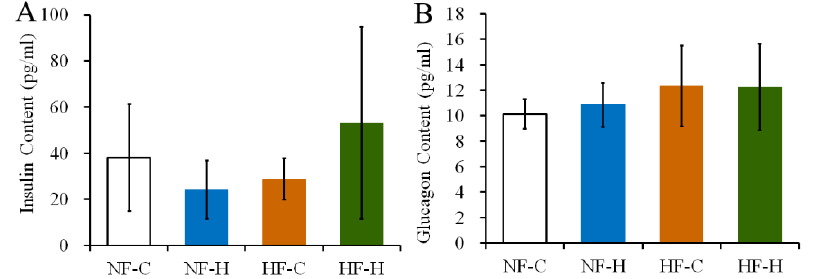
Figure 4. Effects of CPF on serum contents of insulin ( A ) and glucagon ( B ) in rats treated under the NF diet and HF diet. CPF—Chlorpyrifos. NF-CON—fed a normal-fat diet and vehicle. NF-CPF—fed